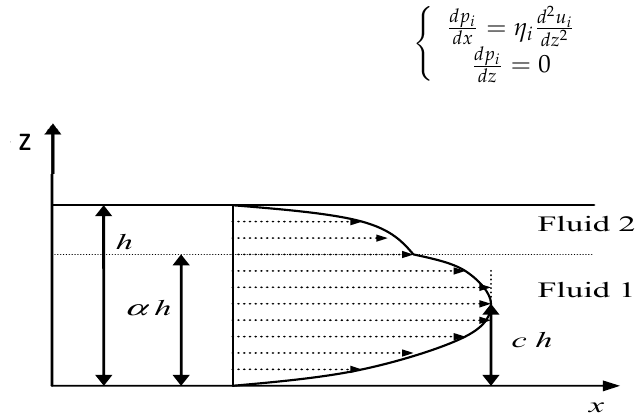
Figure 8. Two-layer flow between parallel plates.